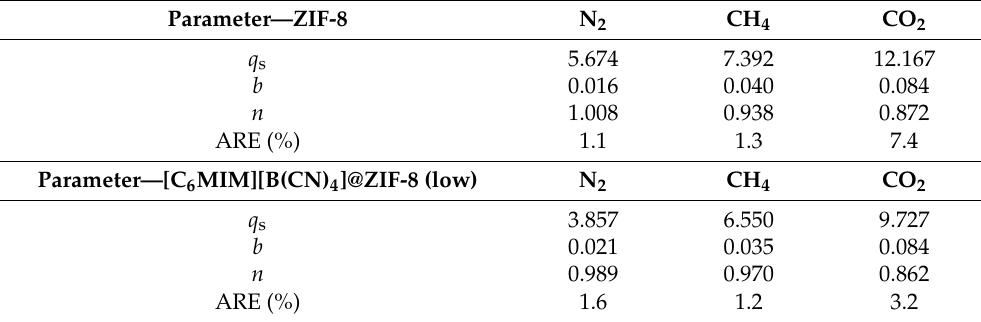
Table 2. Sips model fitting parameters for N 2 , CH 4, and CO 2 on ZIF-8 and [C 6 MIM][B(CN) 4 ]@ZIF-8 (low).